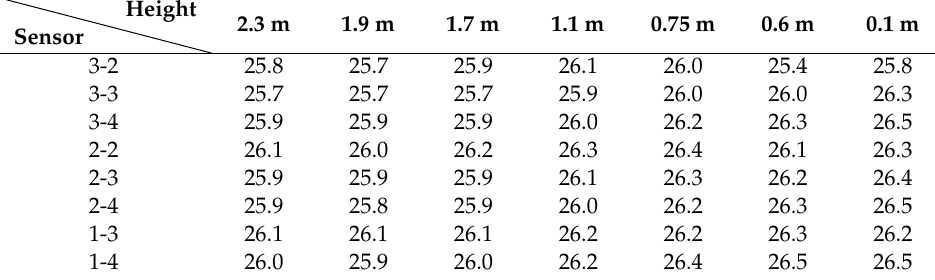
Table 7. Indoor temperature at di ff erent levels under condition C.